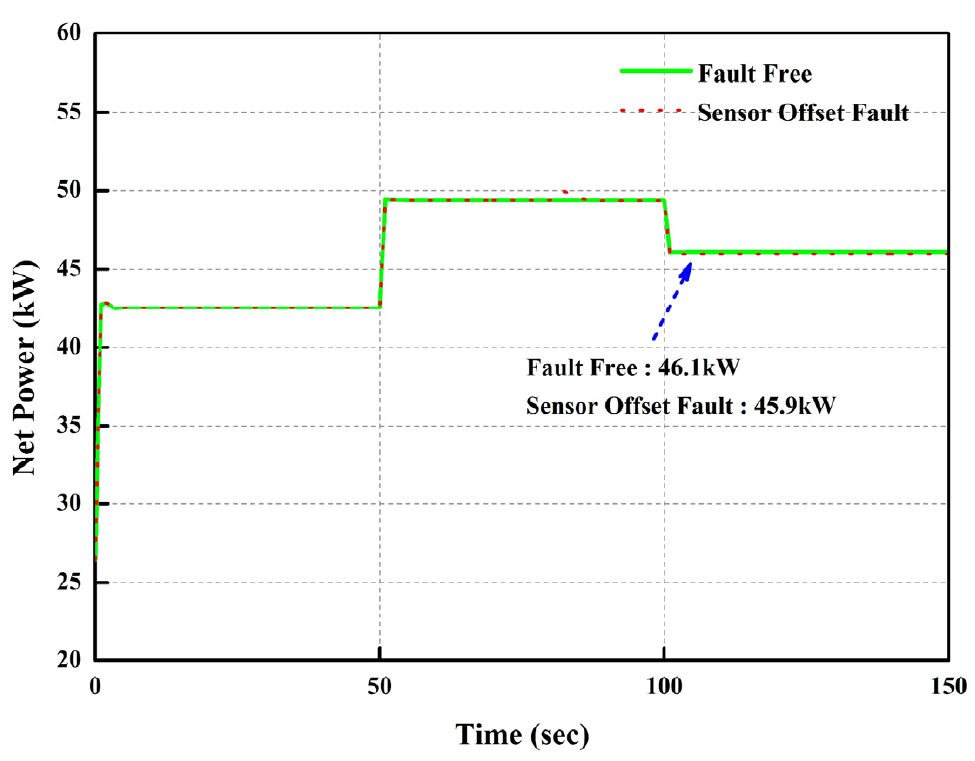
Figure 10. Comparison of net power: Fault-Free Case vs. Sensor Offset Fault.